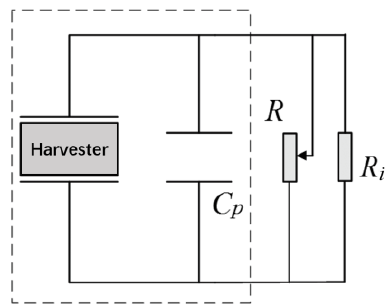
Figure 11. A loop circuit with an adjustable load resistance.